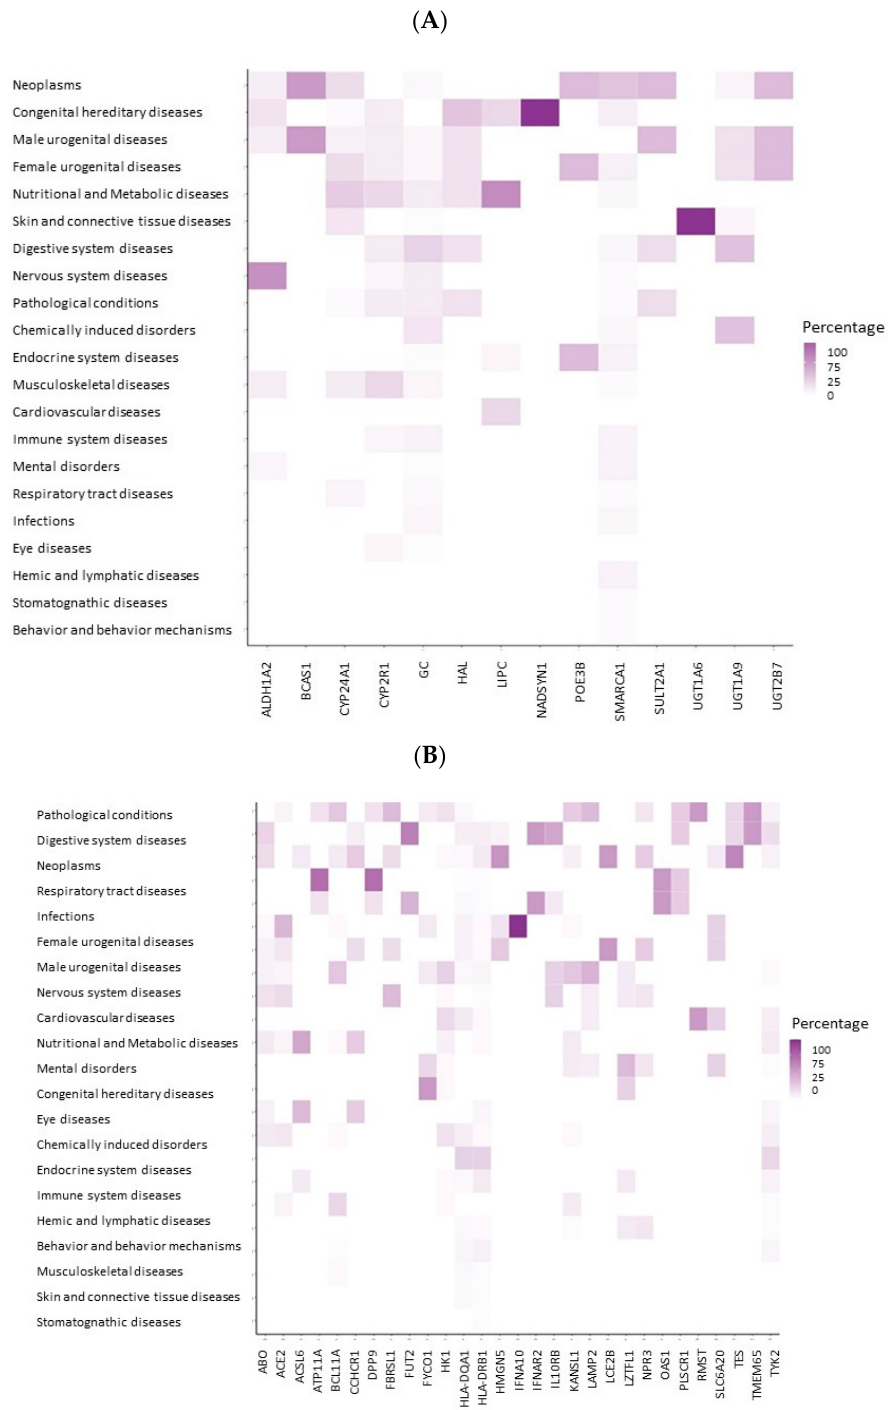
Figure 4. Gene-disease heat map by groups of diseases for VD deficiency genes ( A ) and COVID-19 ( B ). The x-scale shows the list of genes (14 for VD and 29 for COVID-19); the y-axis shows the diseases grouped by the MeSH disease classes. The color scale is proportional to the percentage of diseases in each disease class. Source: DisGeNET .